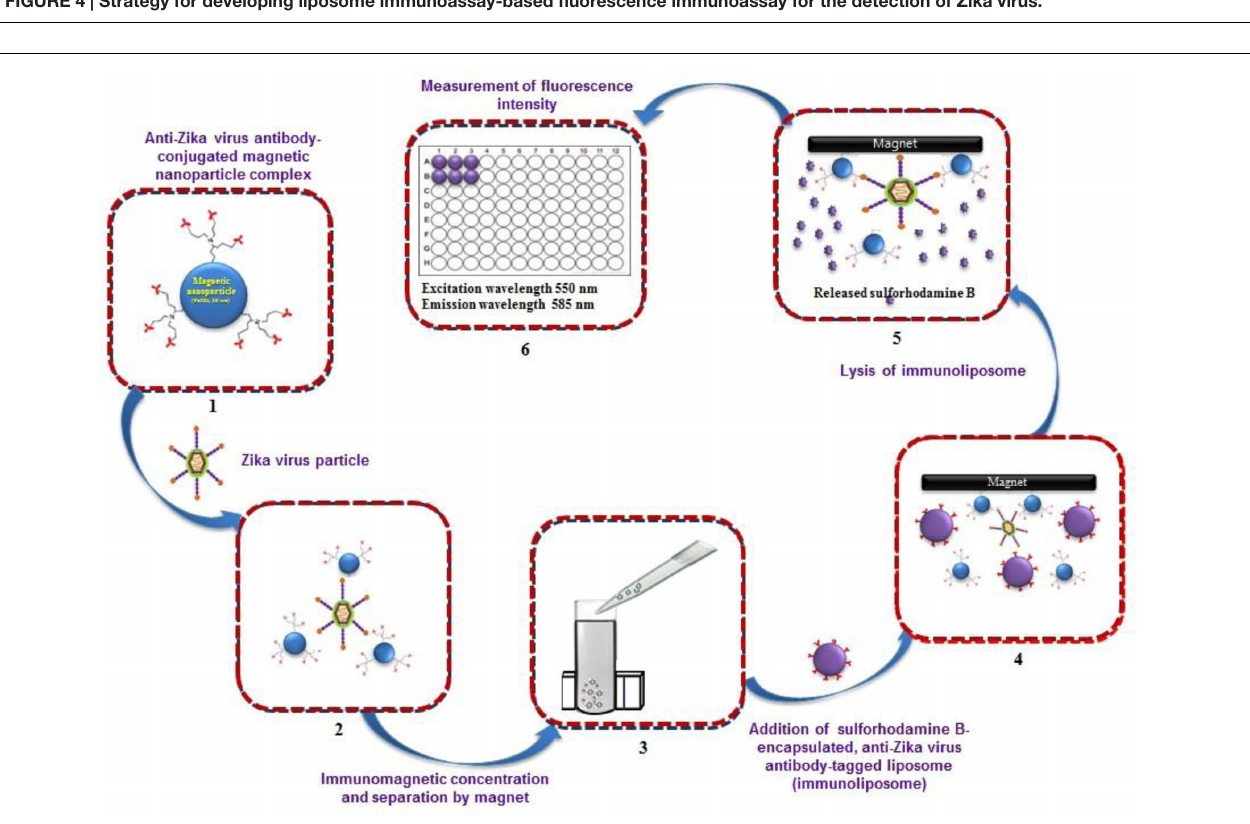
FIGURE 5 | Strategy for developing immunoliposome and immunomagnetic particle-based sensitive detection of Zika virus. (Retrieved from Shukla et al., 2016).